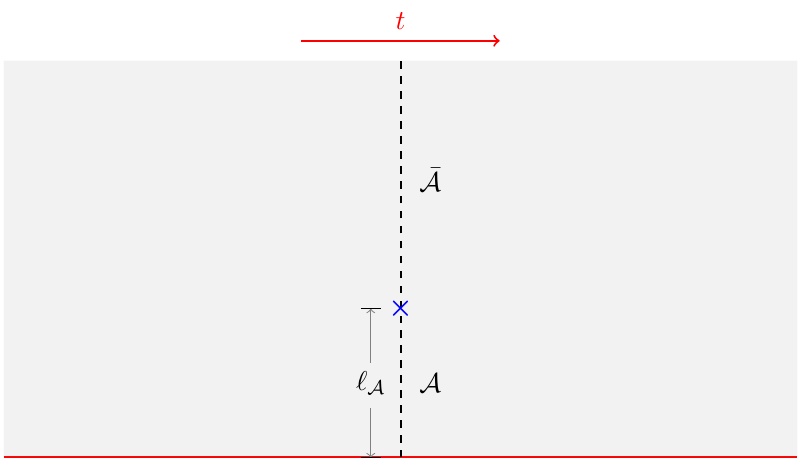
Figure 2 . This diagram shows the situation for a BCFT 2 living on the upper half plane (UHP). We consider bulk CFT to be in the vacuum state. The boundary is specified by the red horizontal axis where we impose conformal boundary conditions. The time direction is along the horizontal axis. We take a constant time slice (dashed black vertical line) that defines the quantum state we are studying. Our goal is to compute the entanglement entropy associated with the bipartition indicated by the blue